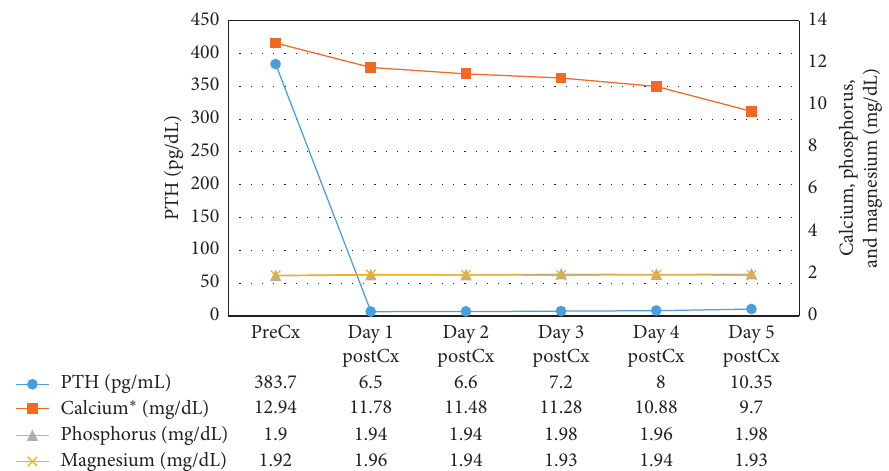
Figure 2: Evolution of serum PTH, calcium, phosphorus, and magnesium levels before and after parathyroidectomy. PreCx: presurgery. PostCx: postsurgery. ∗ Albumin-corrected